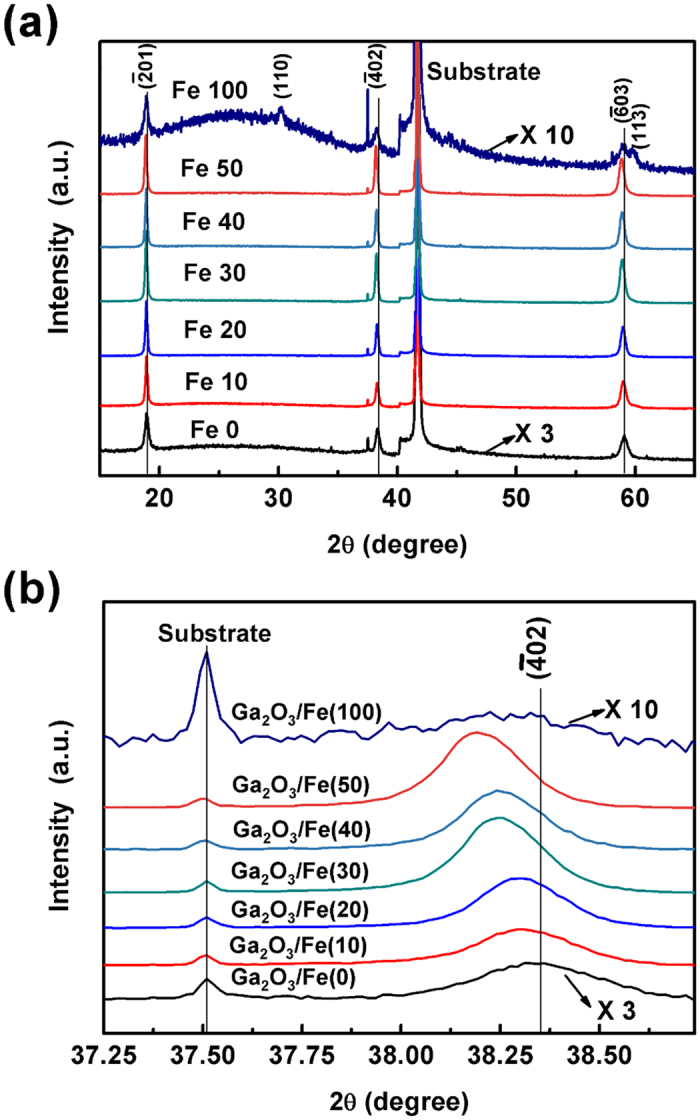
(a) θ–2θ XRD patterns of the Ga2O3/Fe(N) multilayer thin film; (b) Enlarged view of θ–2θ XRD patterns around 38°.